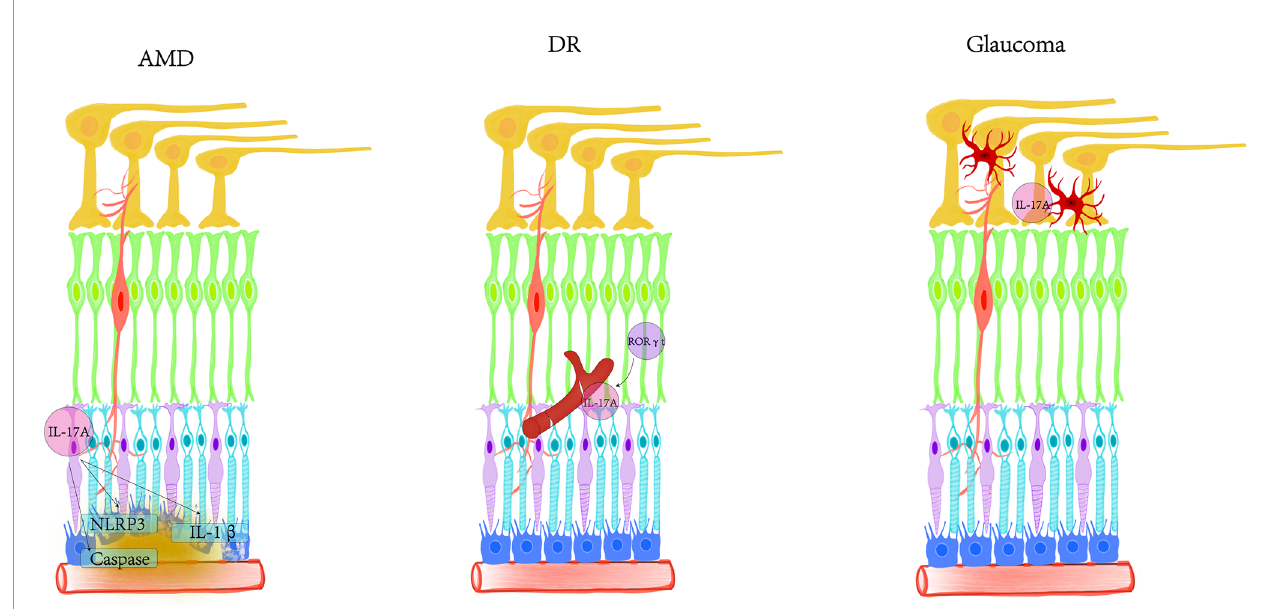
FIGURE 3 | Schematic diagram of the involvement of IL-17A in AMD, DR, and glaucoma. In AMD, IL-17A activates NLRP3, secretes IL-1 b , and induces various signaling pathways in RPE. IL-17A promotes the expression of caspase-1, caspase-3 and caspase-9 pathways from the post-transcriptional level. IL-17A disrupts the distribution of tight junctions and destroys the blood-retinal barrier. IL-17A mainly targets blood vessels in DR, inducing in fl ammation, vascular leakage and capillary degeneration. The cells expressing ROR g t may be the main producers of IL-17A in the retina. In glaucoma, IL-17A was found to be closely related to activated